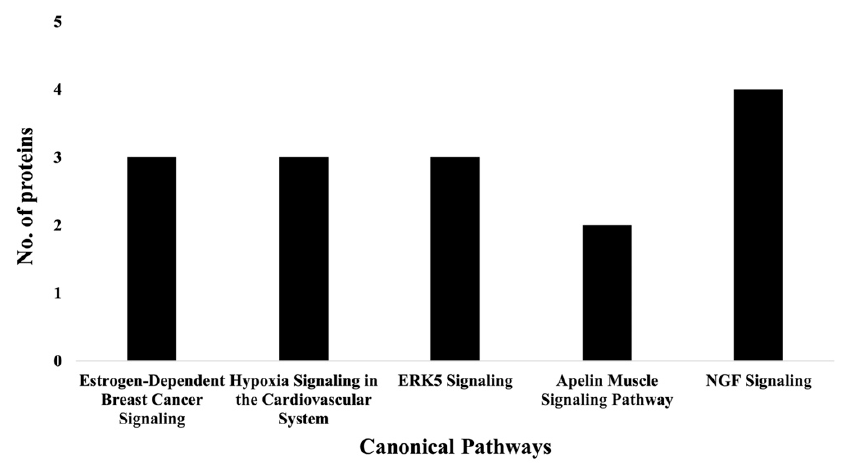
Figure 6. Graph representation of the number of molecules identified in the top 5 canonical path- ways affected by PL (i.e., TAC/PL treatment compared to TAC